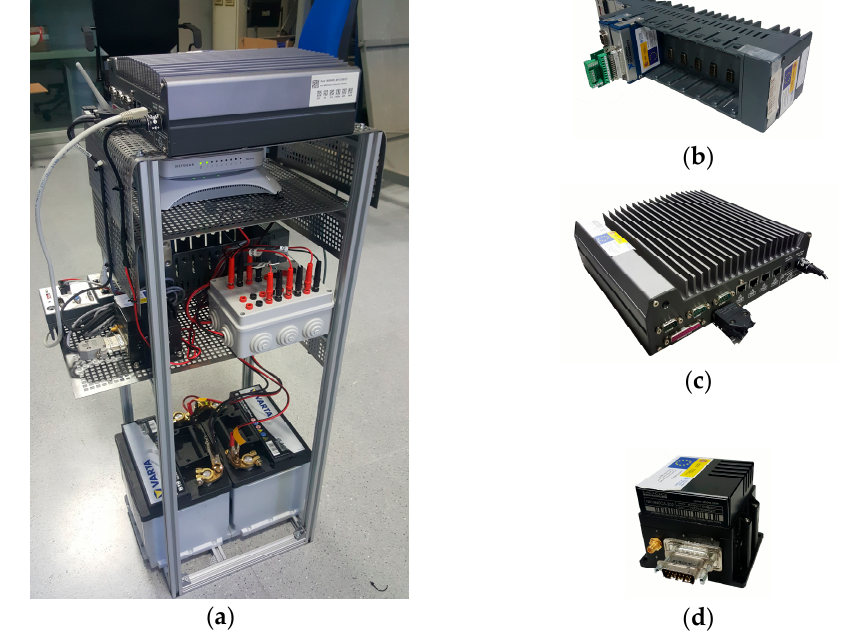
Figure 5. Control system: ( a ) aluminium structure, ( b ) cRIO 9082; ( c ) Emmbebed PC; ( d ) IMU.